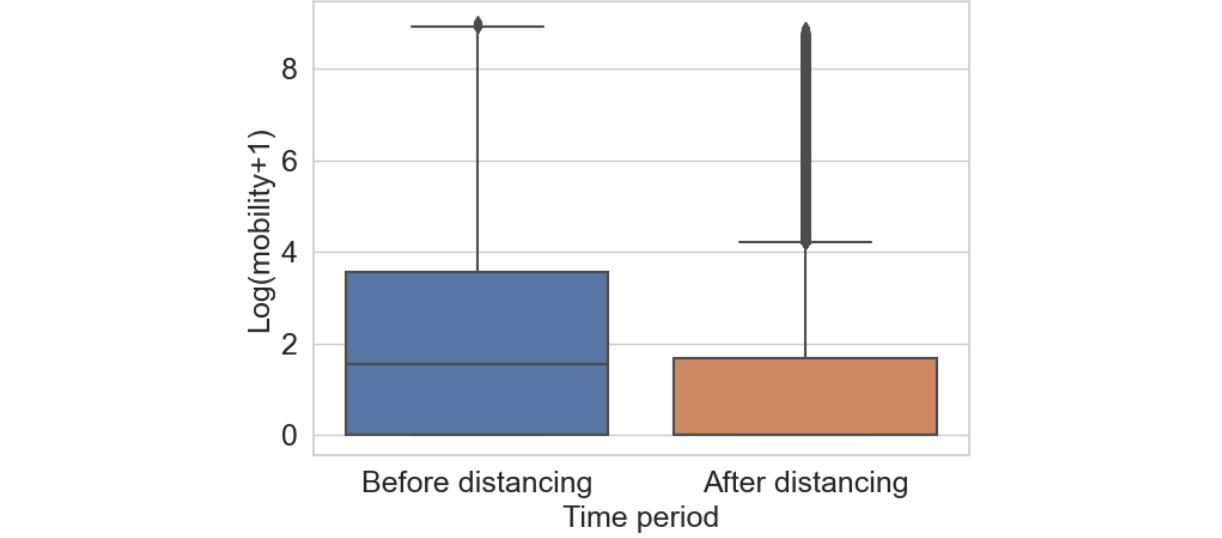
Figure 2. Box plots showing the user distributions of the mean social mobility index (kilometers) before and after social distancing measure were enacted in the United